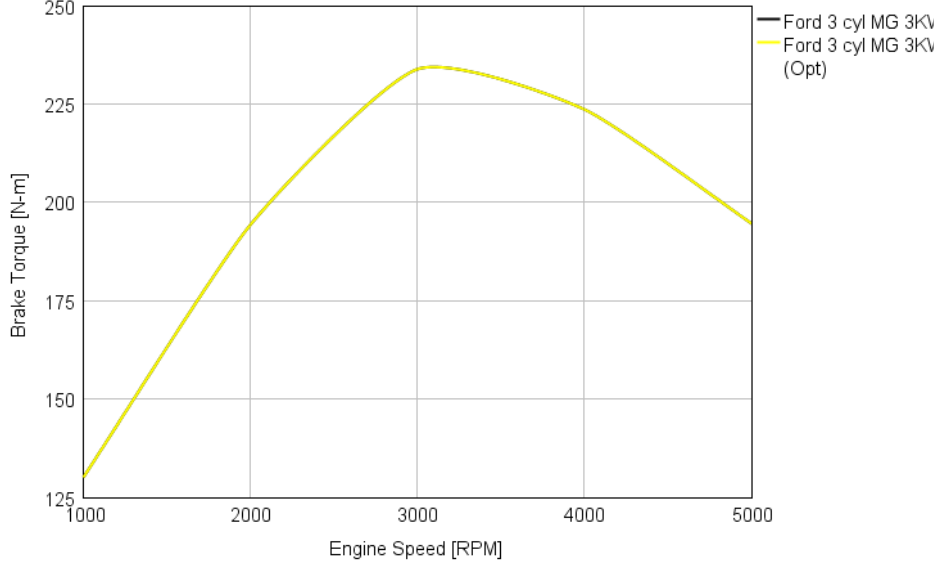
Figure 23. Average Shaft speed of the electrically-assisted turbocharger (EAT) models with 2 kW power level at 1,000 rpm engine speed.